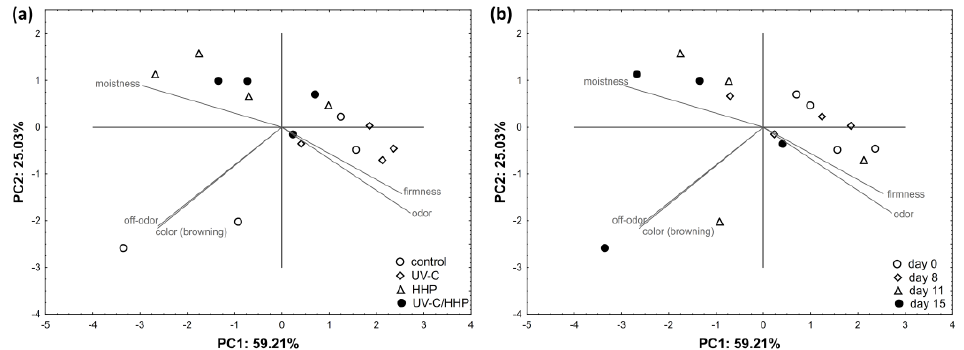
Figure 6. Distribution of raw, fresh-cut potatoes in two-dimensional coordinate system defined by the first two principal components (PC1 and PC2) in relation to the ( a ) treatment and ( b ) storage time.